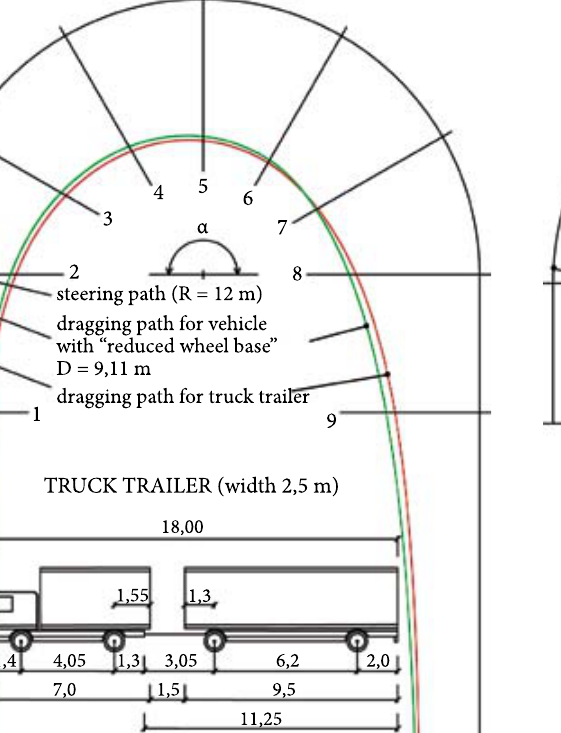
fig. 8. Setting a complex vehicle movement trajectory (tractor semi-trailer) by the method of reduced wheel base Table 4. Difference in traffic lane width for tractor semi-trailer and their replacing vehicle (Fig. 8) Cross-